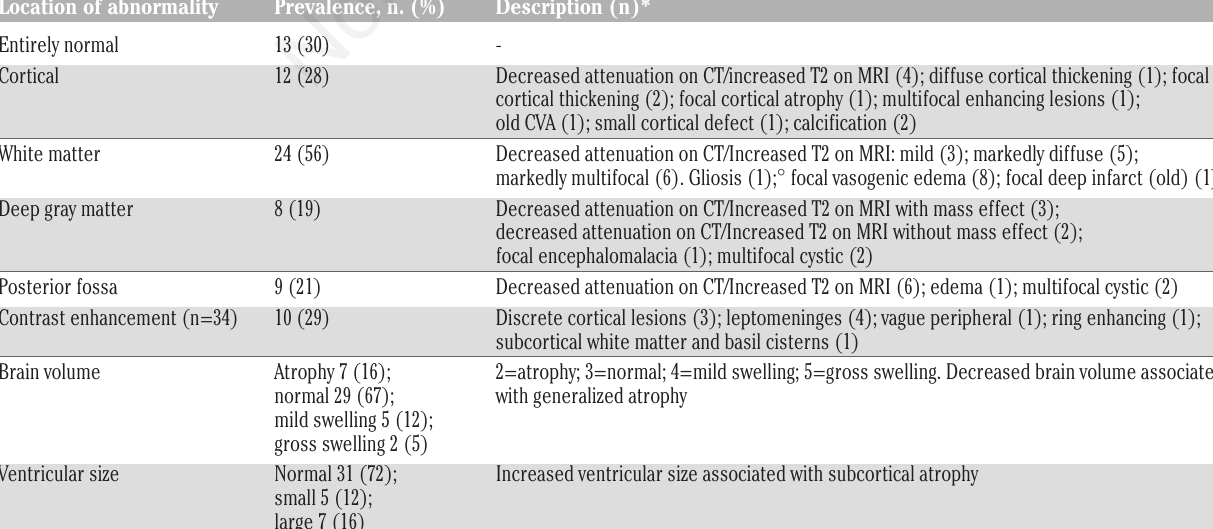
Table 2. Imaging abnormalities identified in HIV+ patients with new onset seizure (n=43). Location of abnormality Prevalence, n. (%) Description (n)* Entirely normal 13